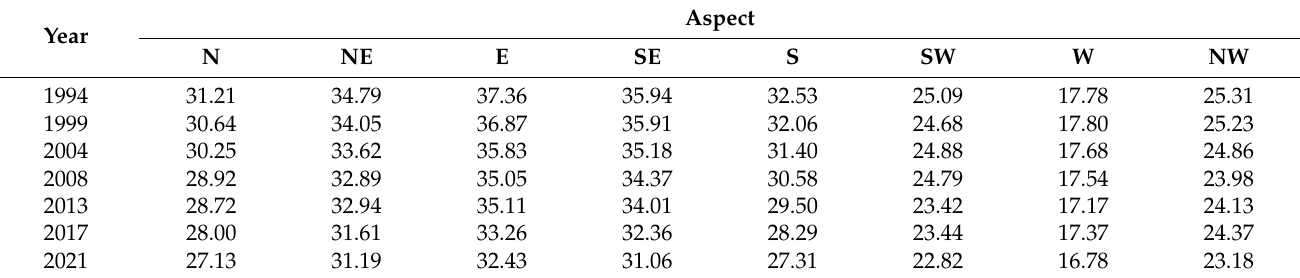
Table 6. The area of glaciers in different slope aspects (unit: km 2 ).